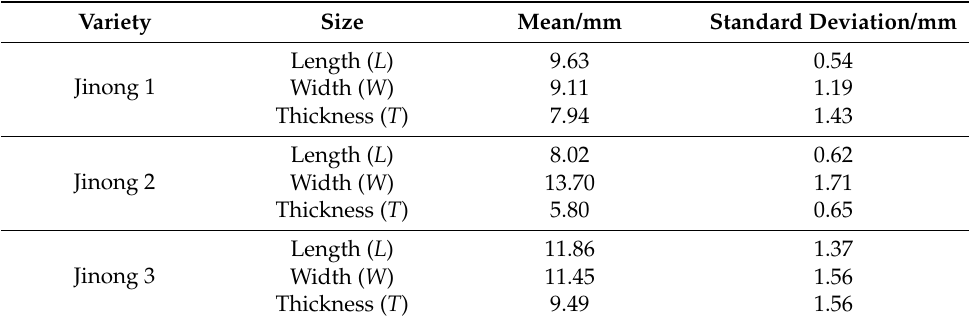
Table 2. Size of the different varieties of Cyperus esculentus seeds. Variety Size Mean/mm